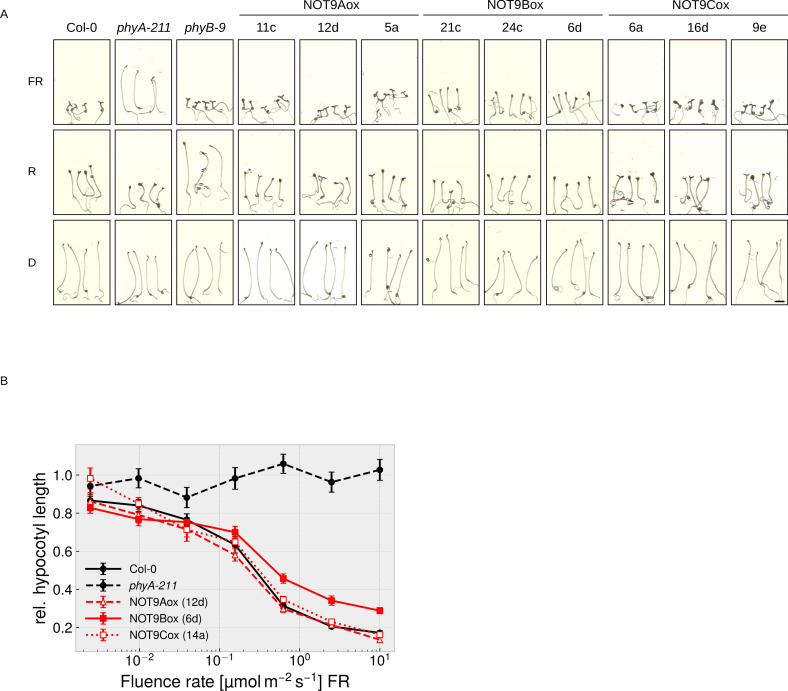
NOT9B homologues do not affect phyA signalling.(A) Fluence rate response curves for inhibition of hypocotyl growth. Seedlings of the indicated genotypes were grown for four days at different fluence rates of FR light or in the dark. Mean hypocotyl length (± SE) of 20 seedlings relative to dark-grown seedlings is shown. (B) Representative seedlings of indicated genotypes were grown for 4 days in R (20 μmol m−2 s−1), FR (40 μmol m−2 s−1), or in D. For each transgene, three independent lines are shown. Scale bar represents 2 mm.